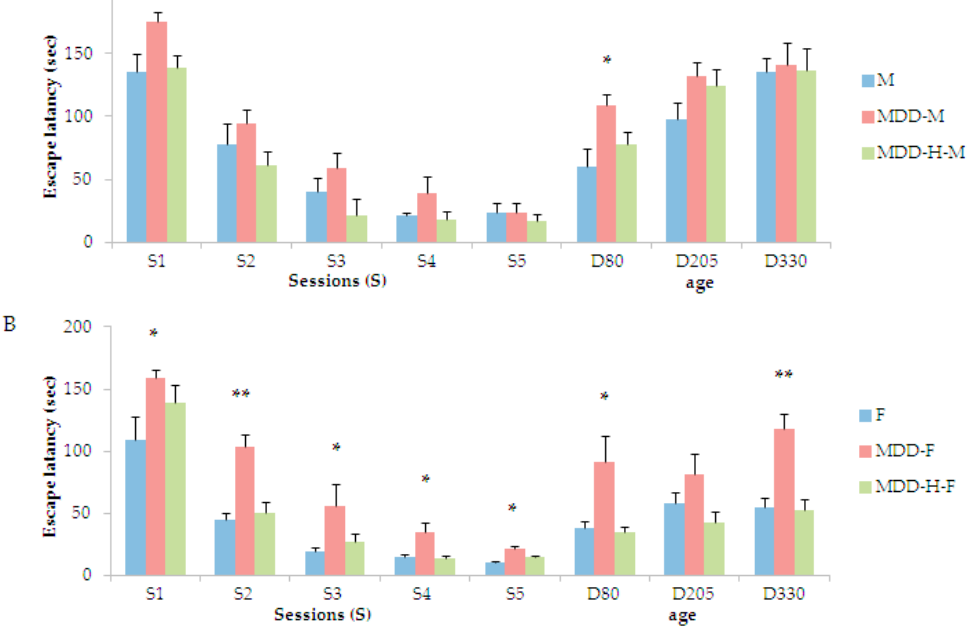
Figure 2. Escape latencies in seconds of ( A ) males (M) and ( B ) females (F) during the learning procedure between D14 and D18 noted as “sessions” (S1 to S5), and at three time points for memory retrieval during adult life (D80, D205, and D330, n = 10 to 15 animals per group). Statistics, * p < 0.05, ** p < 0.01.